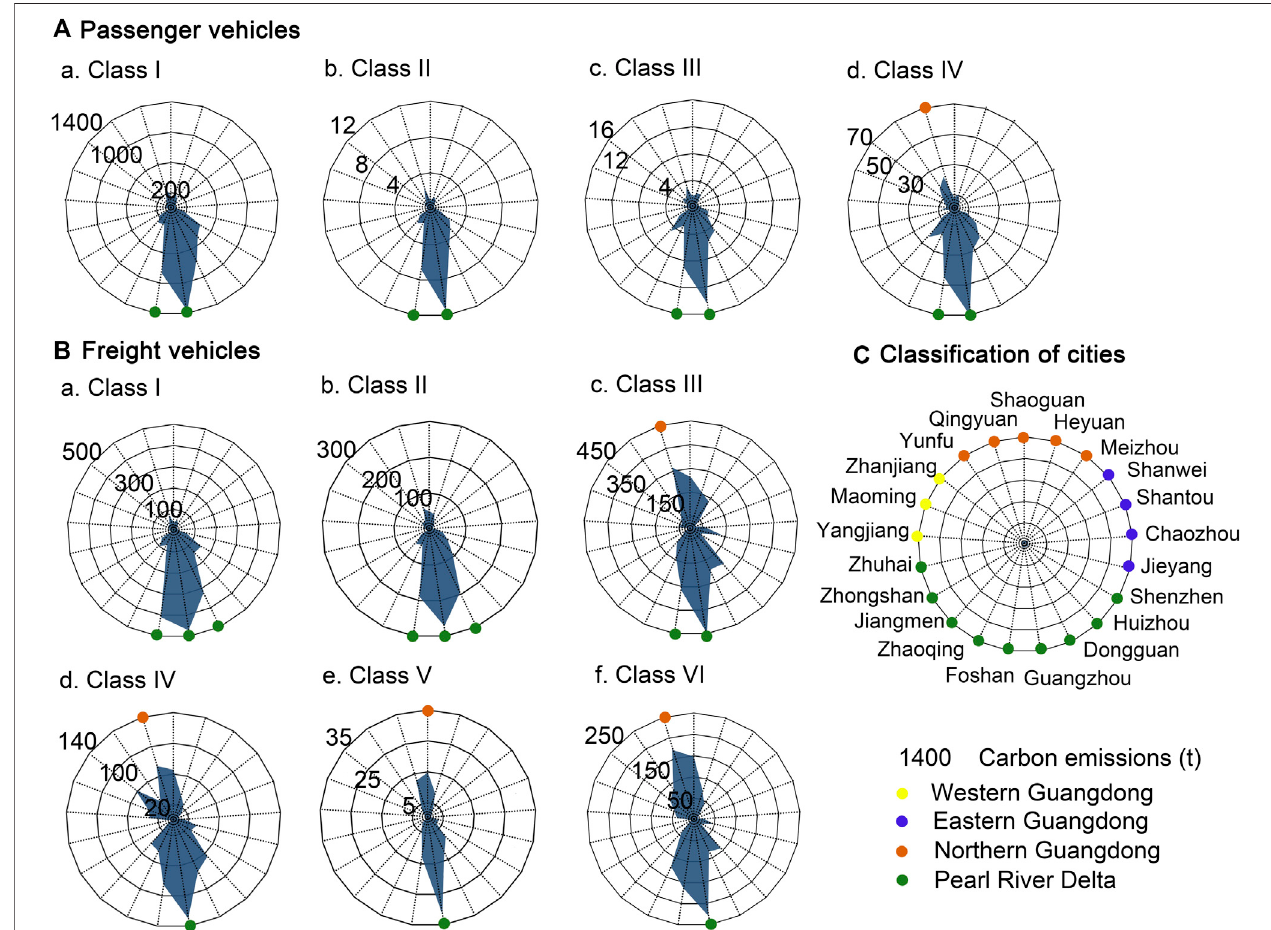
FIGURE 5 | Carbon emissions in different cities by vehicle type and classi fi cation of cities in Guangdong.